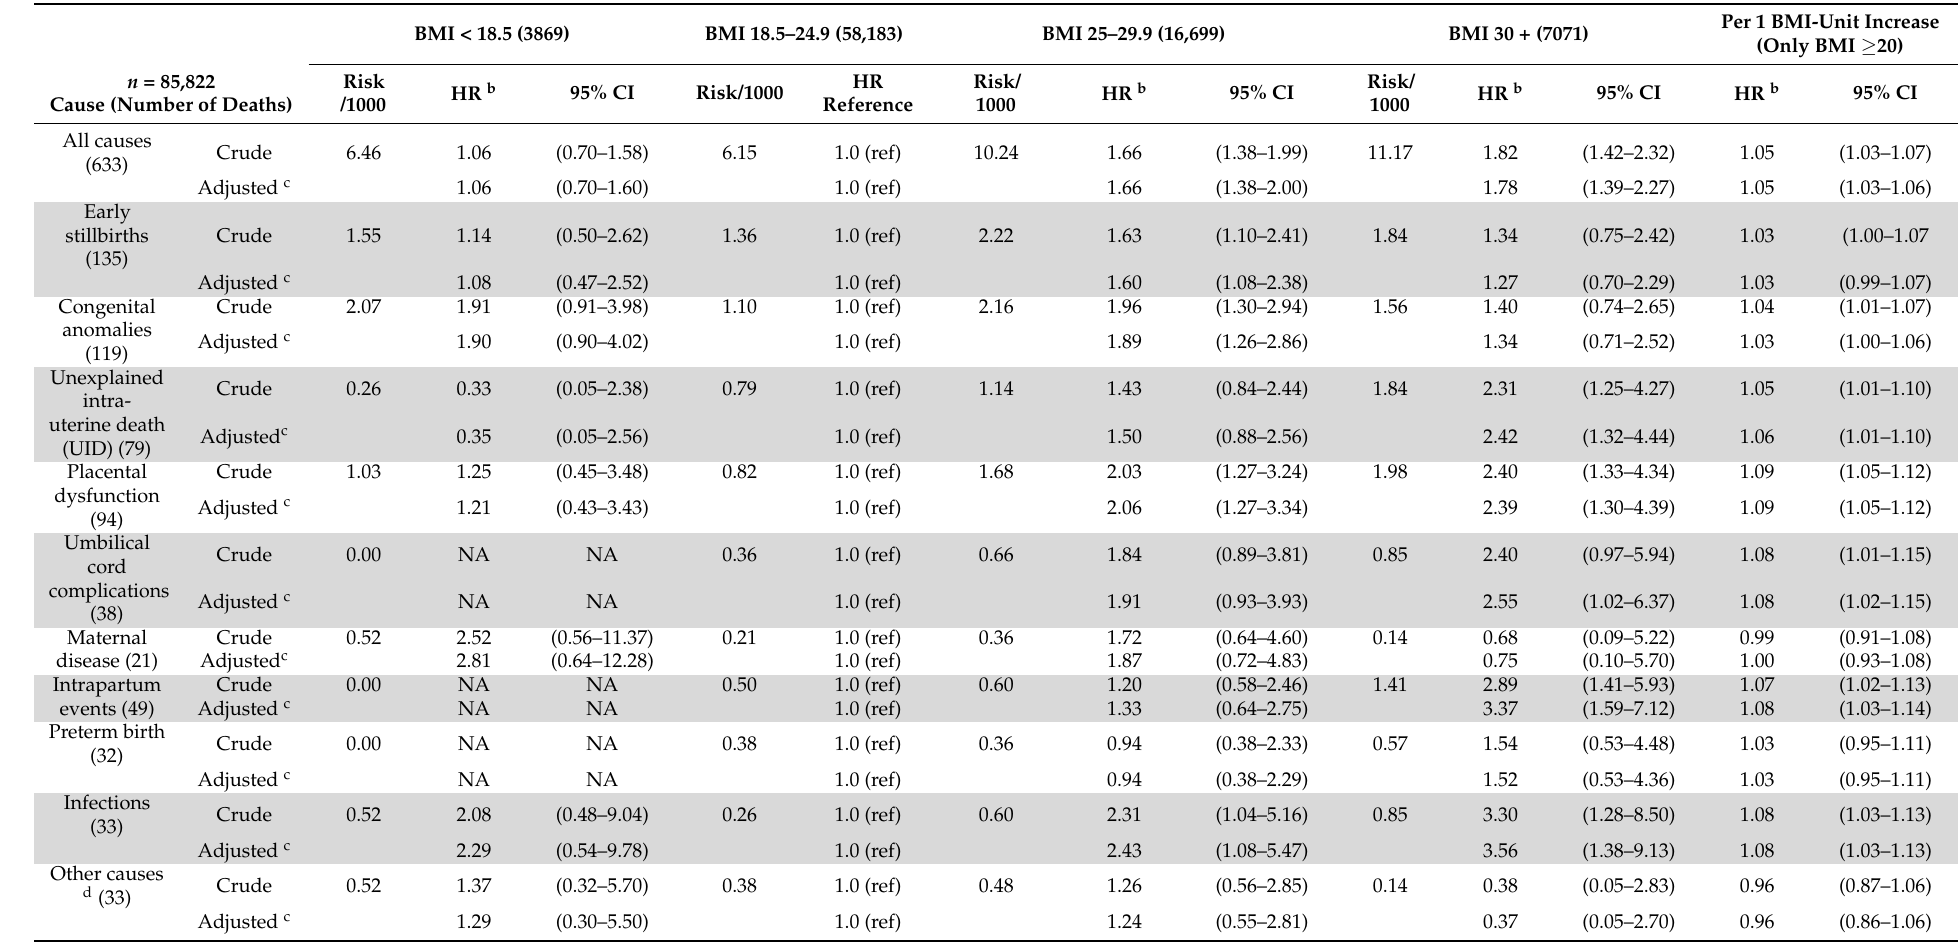
Table 3. Risk of cause-specific stillbirth a or neonatal death a according to prepregnancy body mass